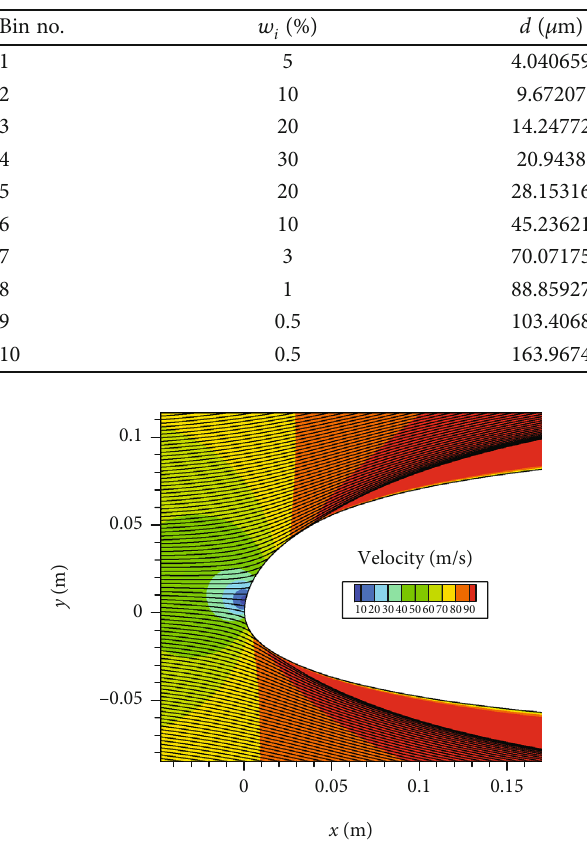
Figure 5: Lagrangian droplet trajectories on contour of air velocity around the MS (1)-0317 airfoil at the droplet diameter of 20.9 μ m.